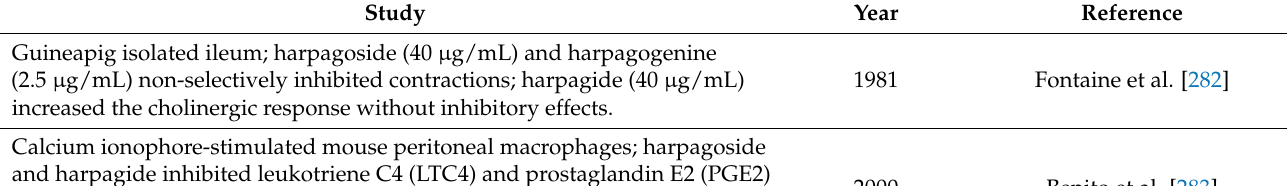
Table 4. In Vitro experiments regarding analgesic/antinociceptive and anti-inflammatory effects of devil’s claw preparations and compounds. Study Year